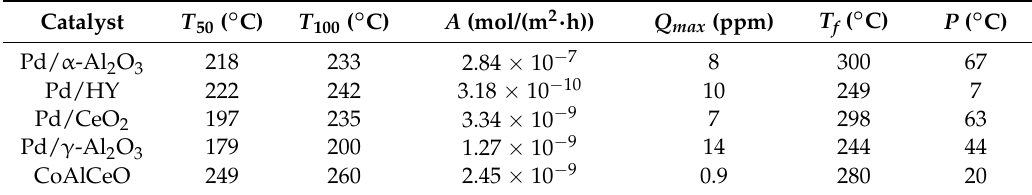
Table 2. T 50 and T 100 of catalysts for toluene catalytic oxidation and parameters characterizing the emission profiles of